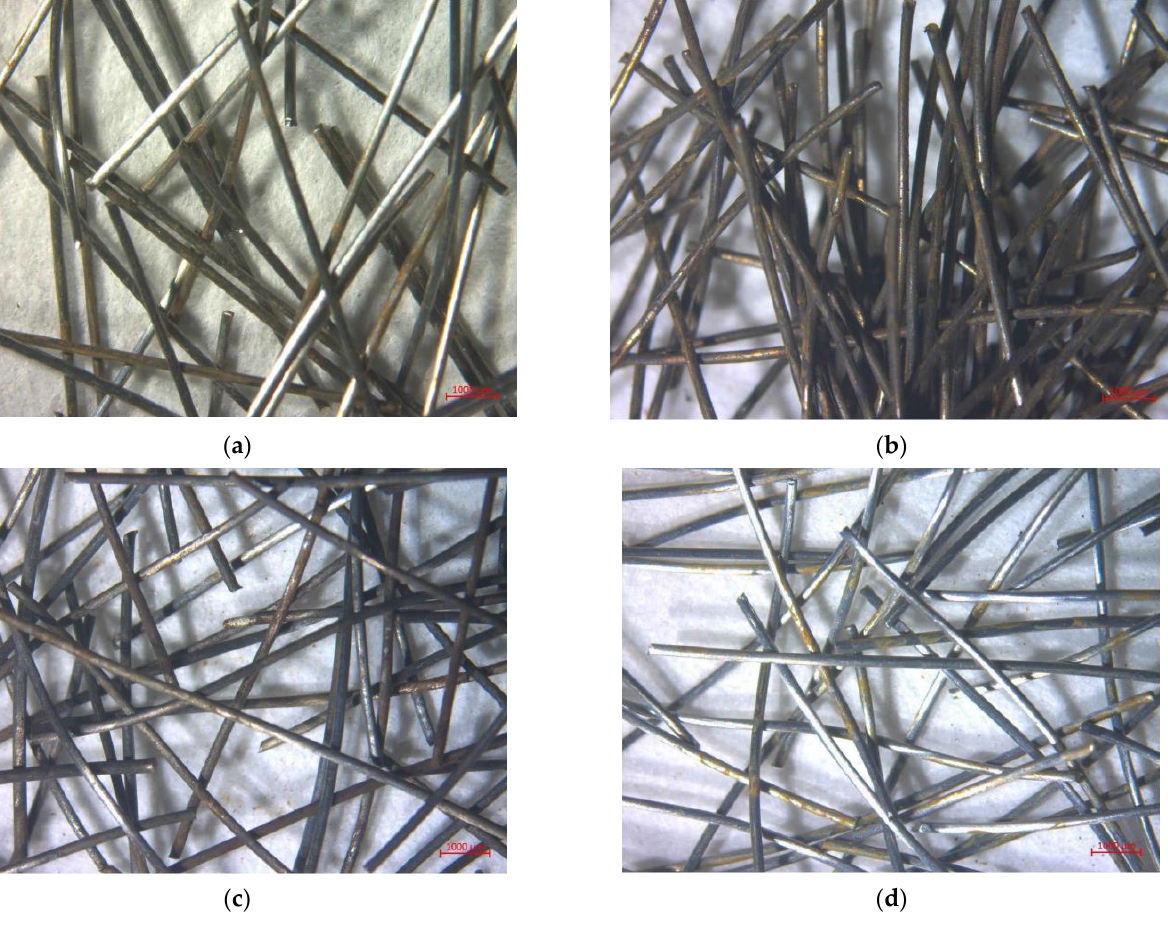
Figure 3. First set of mages from optical microscopy of chemically treated fibers ( a ) Mechanical treatment ( b ) HCl ( c ) HNO 3 ( d ) NH 3 /H 2 O 2.